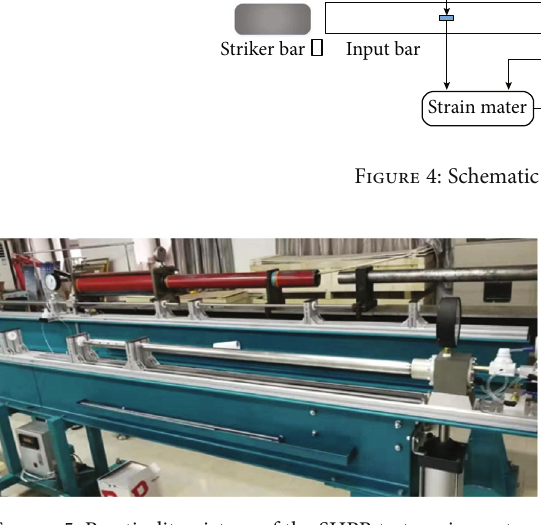
Figure 5: Practicality picture of the SHPB test equipment.